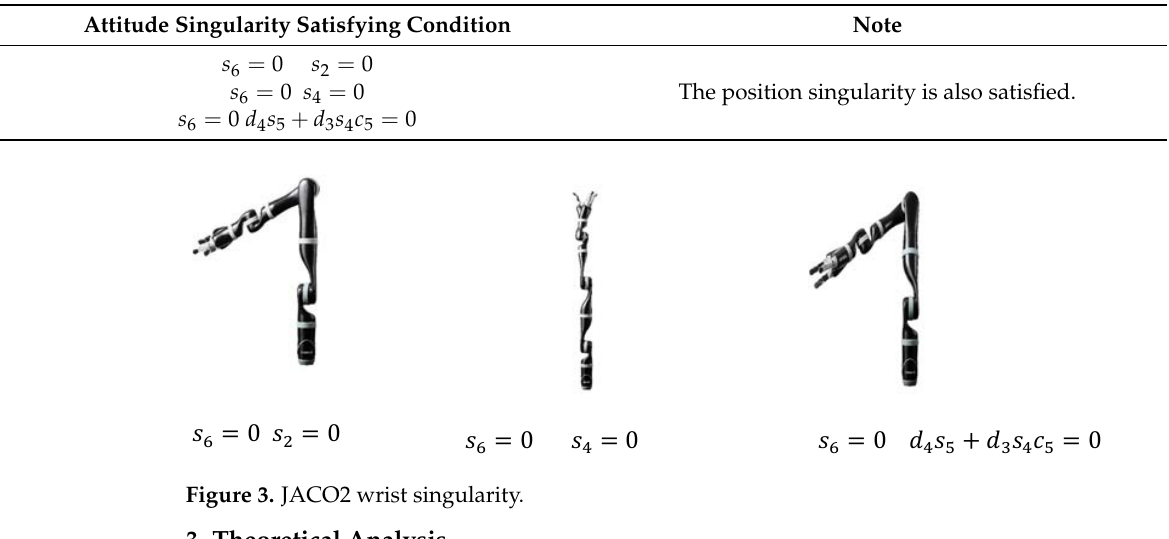
Table 4. The robot attitude singularity condition.